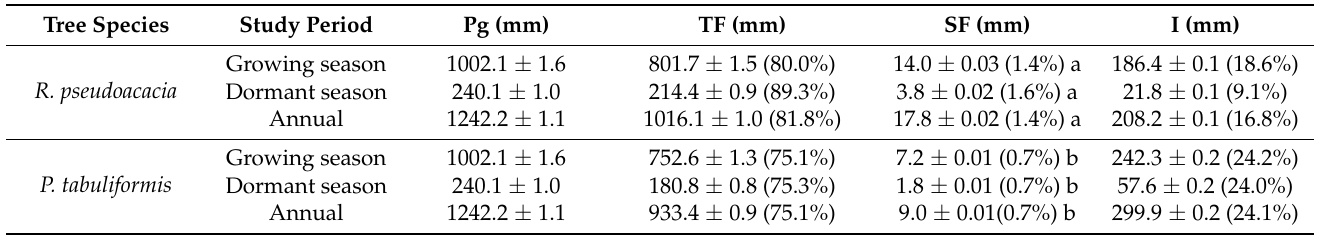
Table 1. Summary of gross rainfall (Pg), throughfall (TF), stemflow (SF), interception loss (I) and relative rainfall partitioning for R. pseudoacacia and P. tabuliformis during both growing and dormant seasons in 2015 and